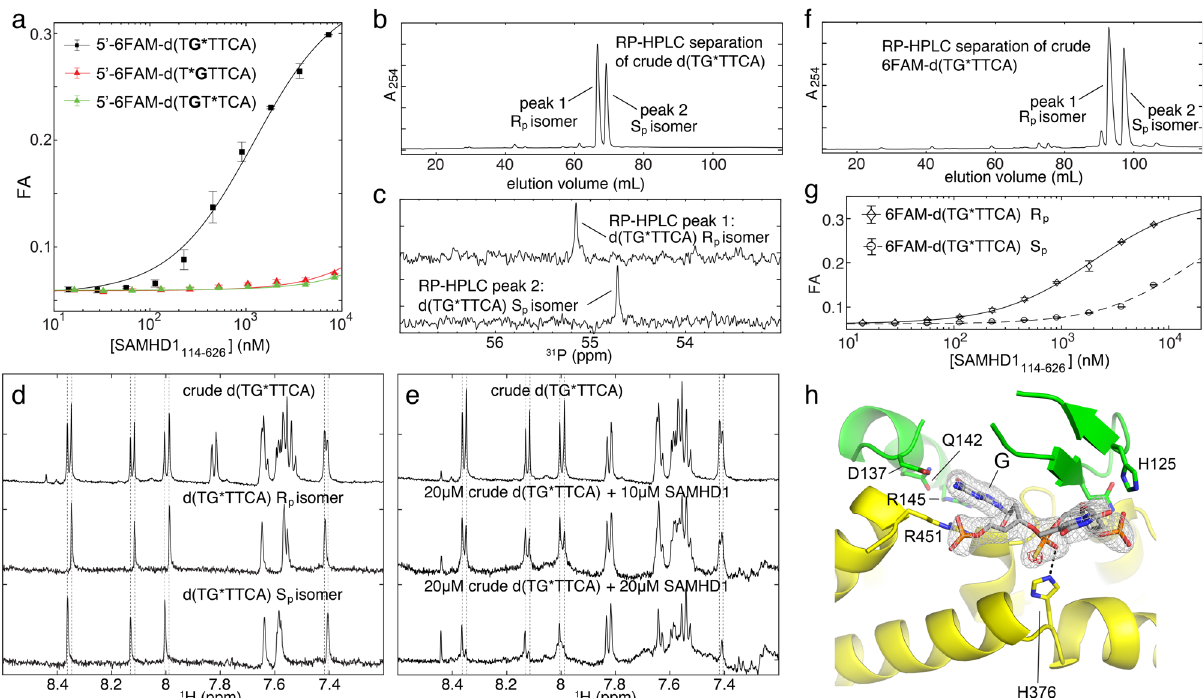
Fig. 3 Stereospeci fi city of the SAMHD1 – GpsN binding. a Location of the phosphorothioate bond within the oligo is a determinant of SAMHD1-binding af fi nity ( n = 2 independent experiments). b Rp and Sp diastereomers can be separated by reverse-phase chromatography. c Sp and Rp diastereomers can be identi fi ed using 31 P NMR 60 . d Doublet peaks in the 1 H NMR spectra can be assigned to Sp and Rp stereoisomers. e Addition of SAMHD1 to crude d (TG*TTCA) oligos selectively broadens NMR signals of the Rp stereoisomer. f Puri fi cation of 6FAM-labeled Rp and Sp diastereomers by reverse-phase chromatography. g SAMHD1 displays about tenfold higher af fi nity for the Rp stereoisomer of 6FAM-d(TG*TTCA) ( n = 2 independent experiments). h Difference (black) and anomalous difference Fourier (red) diffraction electron-density maps reveal that in the crystals of the SAMHD1:d(TG*TTCA) complex, the bound oligonucleotide is the Rp stereoisomer. The mesh shows the composite 2mFo-DFc omit map contoured at 1.5 σ . Error bars represent s. d. of two replicate measurements performed on distinct samples. Source data are provided as a Source Data